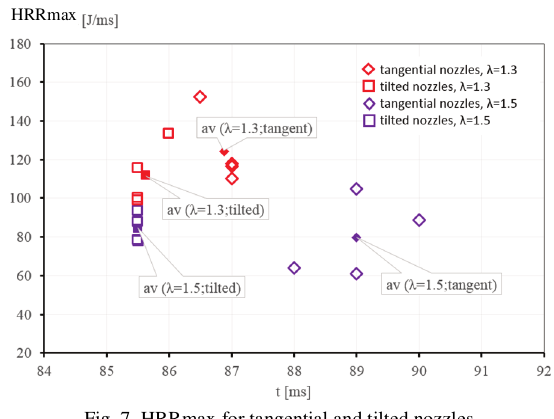
Fig. 7. HRRmax for tangential and tilted nozzles Based on the cylinder pressure signal, the HRR values over their occurrence time at λ = 1.3 and λ = 1.5 (red and violet color respectively) for tangential (rotated squares) and tilted (squares) nozzles have been indicated for the single combustion cycles (Fig. 7). At high load points ( λ = = 1.3), tangential nozzles provided approximately 9% big- ger average value of HRRmax, which has been however retarded for 1.2 ms. At low load points ( λ = 1.5), the tilted nozzles caused 4% bigger HRRmax. However, for both investigated λ , the occurrence of HRRmax indicates much smaller spread, when the tilted nozzles have been used. The better mixing characteristic with use of tilted nozzles results in smaller cyclic variability of Pmax and